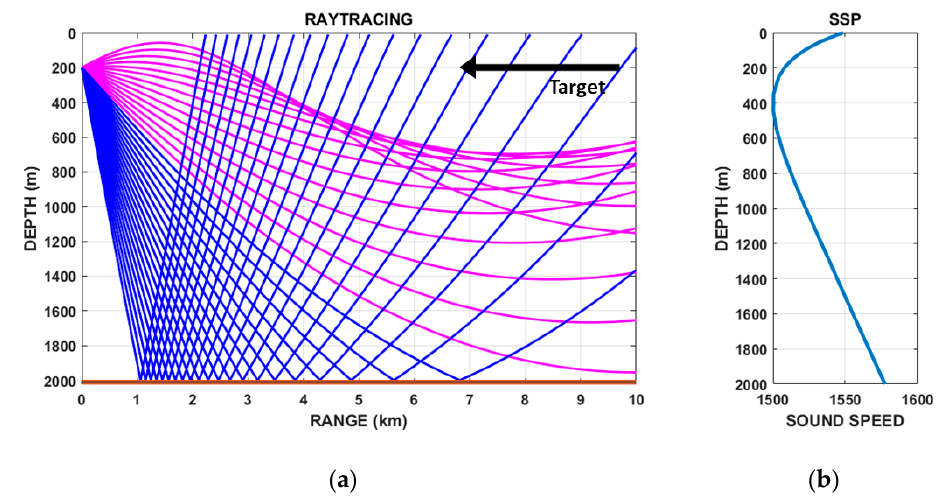
Figure 3. ( a ) Ray paths predicted by ray tracing method based on ( b ) Munk’s sound speed profile. Direct and bottom bounce paths are plotted with magenta and blue lines, respectively.